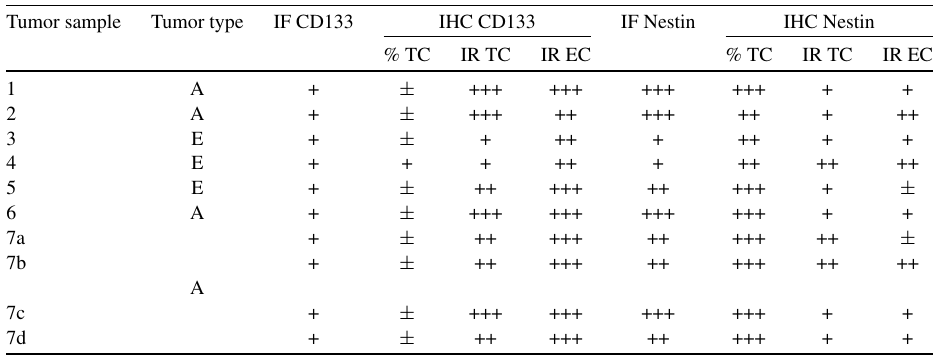
Immunohistochemical and immunofluorescence analysis of CD133 and nestin expression in rhabdomyosarcomas Tumor